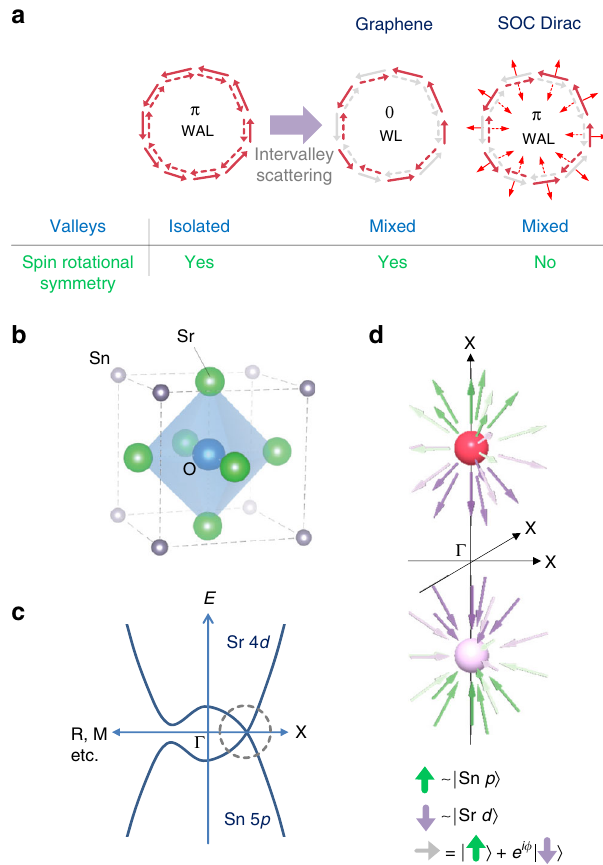
Fig. 1 Pseudospin and spin in antiperovskites. a Pseudospin-momentum locking induces a π phase shift for the two electron trajectories (antilocalization). Intervalley mixing causes weak localization for a system with spin-rotational symmetry. A Dirac system with strong spin – orbit coupling could give rise to antilocalization when valleys are mixed since spin-rotational symmetry is broken. b Antiperovskite structure of Sr 3 SnO. The anion (O) is surrounded by cations (Sr), unlike in normal perovskites, where anion and cation positions are exchanged. c Highly schematic diagram showing band inversion of Sr and Sn bands, which produces Dirac nodes along Γ – X momentum directions. d Two of the six Dirac pockets which form under moderate hole doping are shown. The arrows represent pseudospins consisting of wavefunctions originating mainly from Sn p states and Sr d